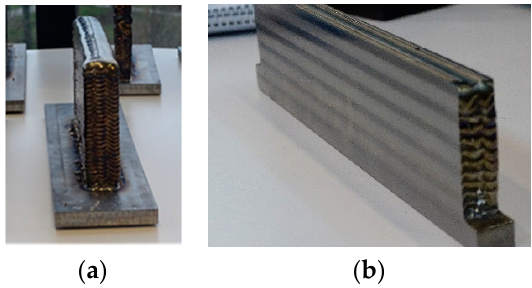
Figure 3. Walls preparation by Plasma Arc Welding (PAW)-Wire Arc Additive Manufacturing (WAAM)